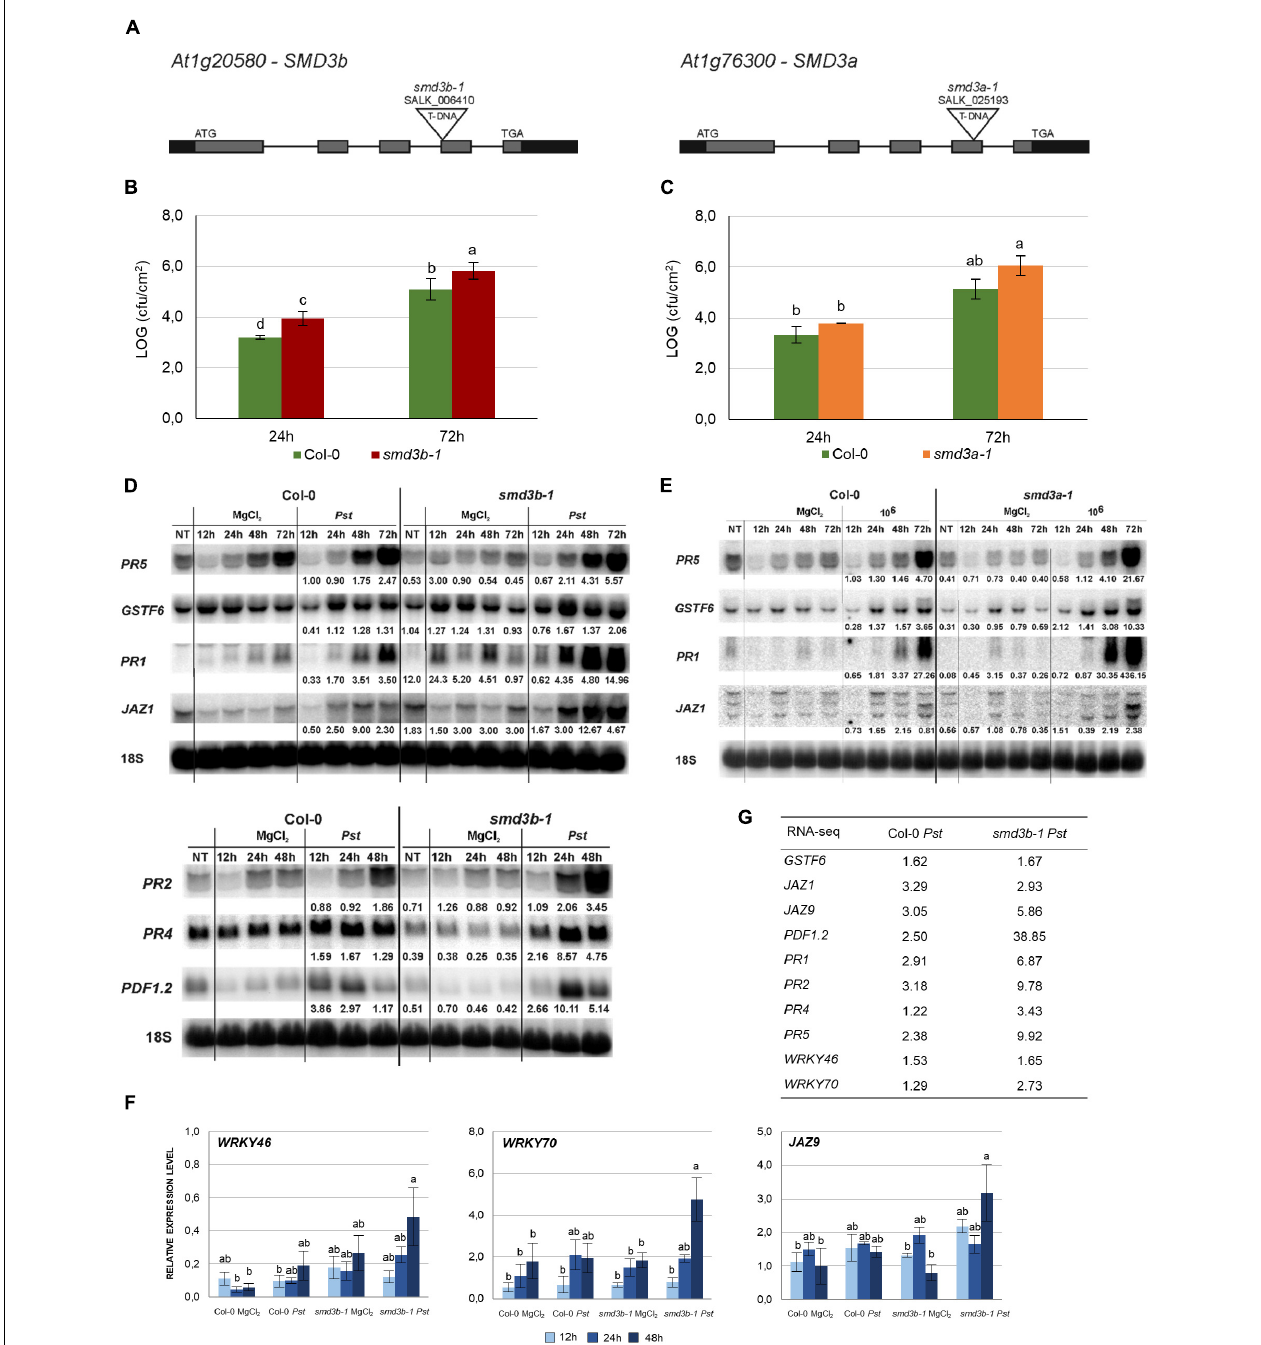
FIGURE 1 | The smd3b-1 and smd3a-1 mutants are susceptible to Pseudomonas syringae pv. tomato DC3000 infection. (A) Structure of the AtSMD3-B ( At1g20580 ) and AtSMD3-A ( At1g76300 ) genes. Exons are represented by gray bars, UTRs by black bars and localization of T-DNA insertions are indicated. (B,C) Growth of Pst DC3000 after 24 and 72 hpi in Col-0 and the smd3b-1 (B) or smd3a-1 (C) mutant. For each time point leaf disks were collected from 5 plants. Results are mean of four independent experiments and error bars represent SEM; letters represent significant difference ( P < 0.05) for Tukey’s HSD test. (D,E) Northern blot analysis of factors involved in response to Pst DC3000. Samples were collected from non-treated (NT), control (MgCl 2 ) and infected ( Pst ) Col-0 and smd3b-1 (D) or smd3a-1 (E) plants at indicated time points. Numbers represent the ratio of transcript level in Pst- treated Col-0 and mutants relative to control and normalized to 18S rRNA loading control. Experiments were repeated at least three times; representative blots are shown. (F) RT-qPCR analysis of selected pathogen response genes in smd3b-1 . Mean values ± SEM were obtained from three independent experiments; letters represent significant difference ( P < 0.05) for Tukey’s HSD test. UBC9 mRNA was used as a reference. (G) The expression levels of selected pathogen response genes in Col-0 and the smd3b-1 mutant based on RNA-seq analysis. Numbers represent fold change.